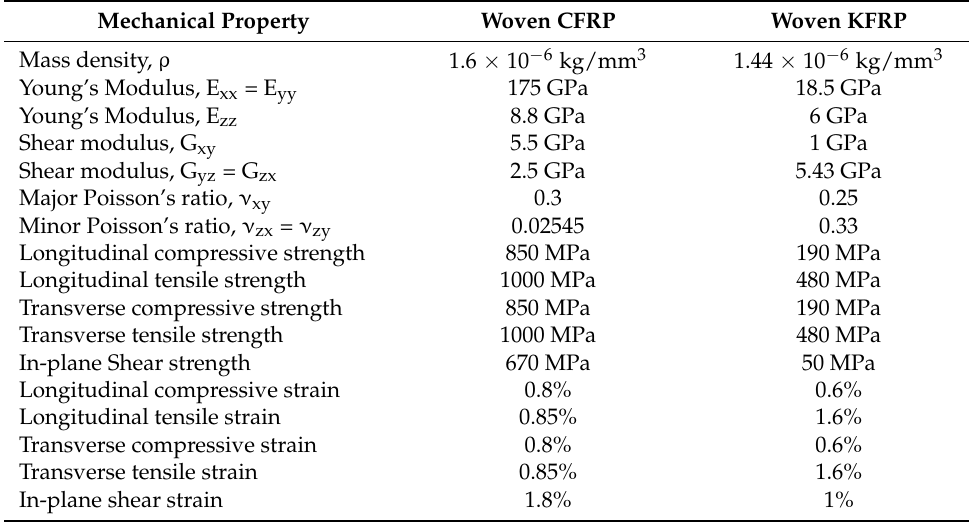
Table 3. The material properties are defined in